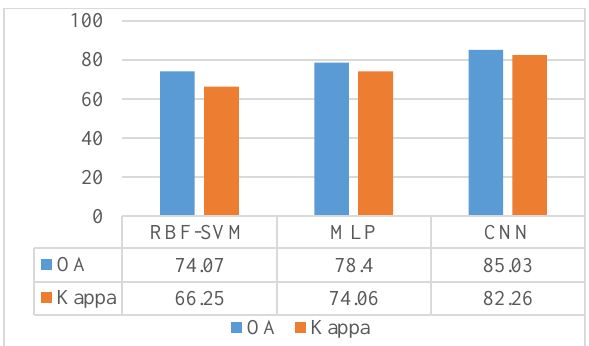
Figure 5. Comparison of different classification results obtained by the RBF-SVM, the MLP, and the proposed CNN-based